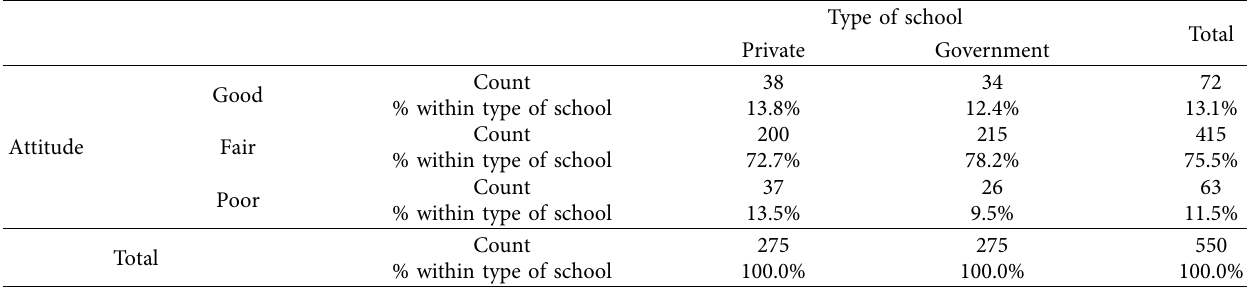
Table 6: Distribution of school teachers based on their attitude and type of school.